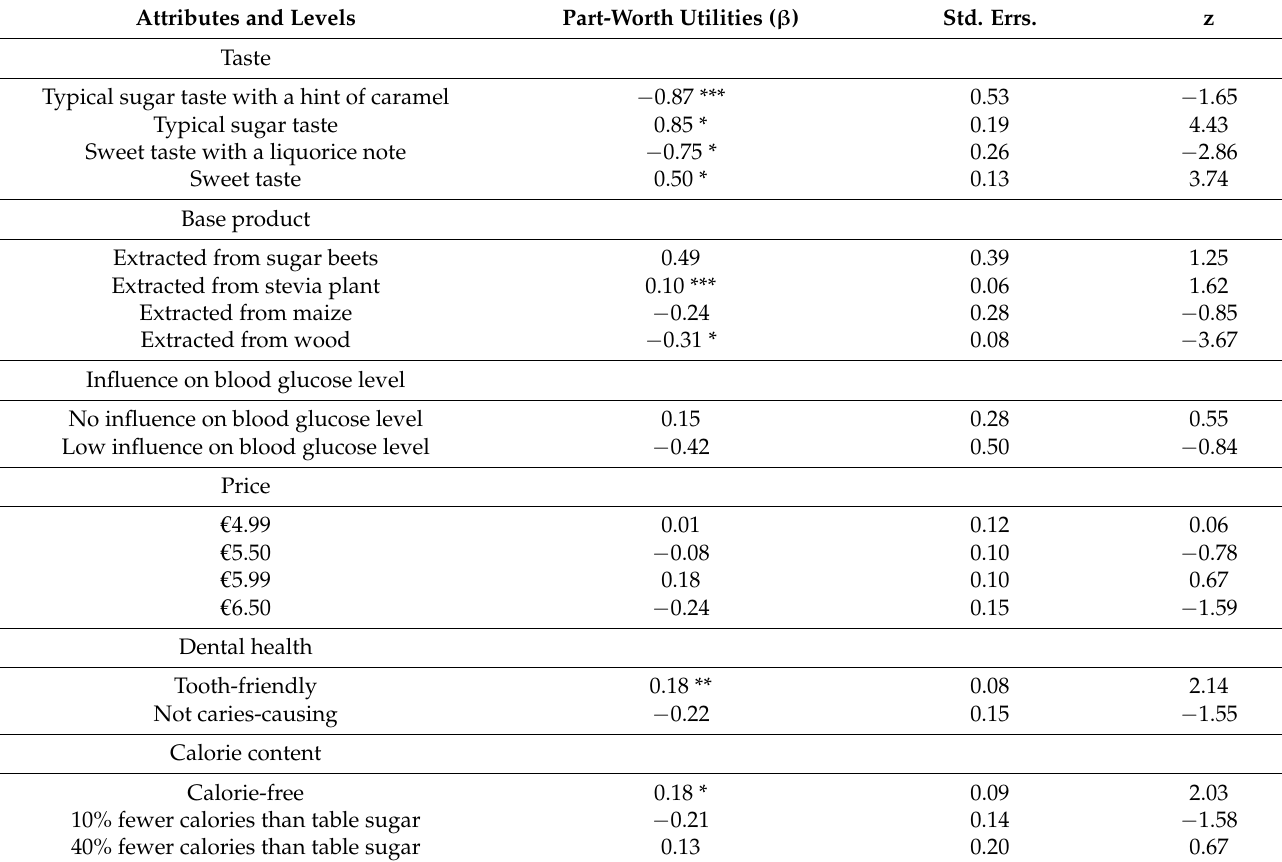
Table 4. Part-worth utilities of all levels.